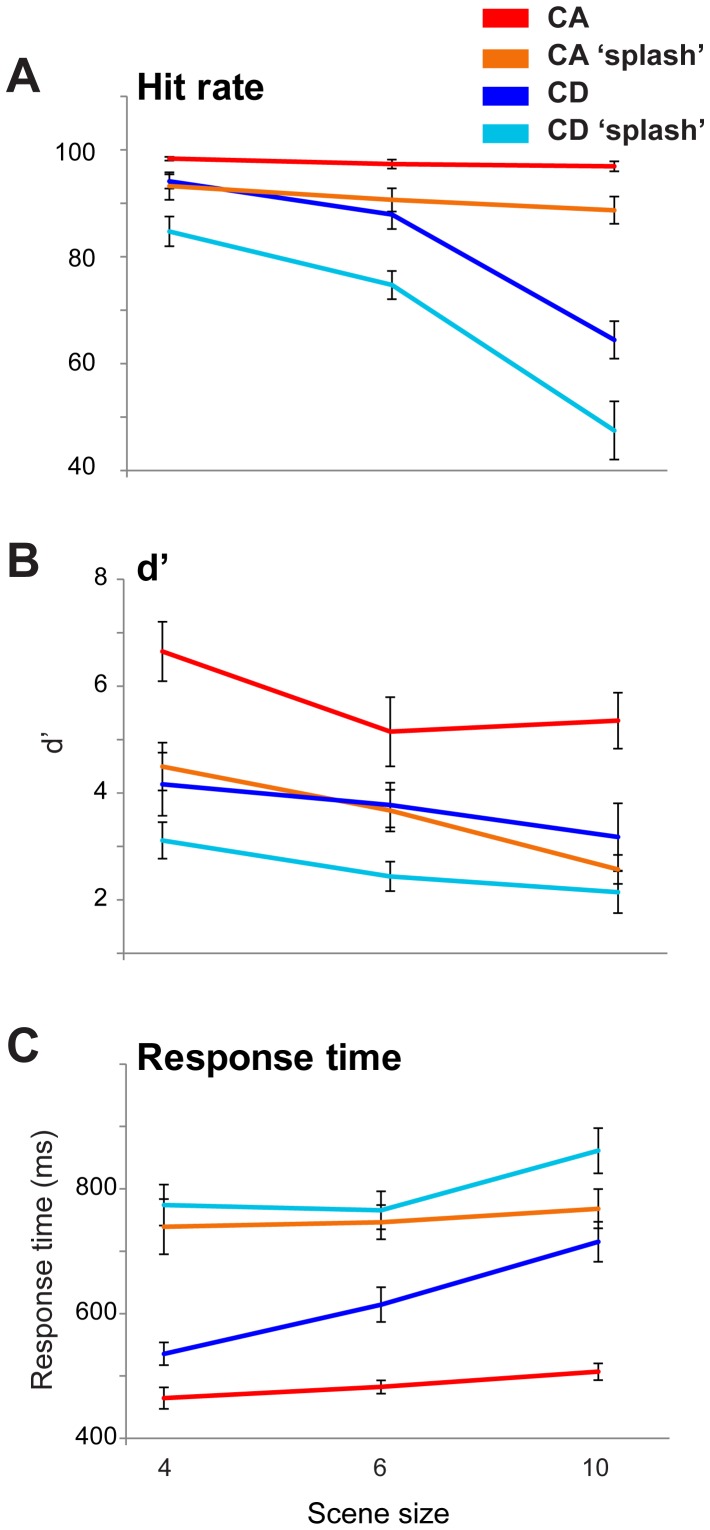
Results of Experiment 7, comparing performance on non-interrupted scenes and those where a brief acoustic ‘splash’ occurred at the time of change.Error bars are 1 SE. Note that the scenes sizes used here are different from the previous experiments. Reducing the maximum scene size to 10 (rather than 14) was necessary because ‘splash’ components and scene elements shared the same frequency pool.